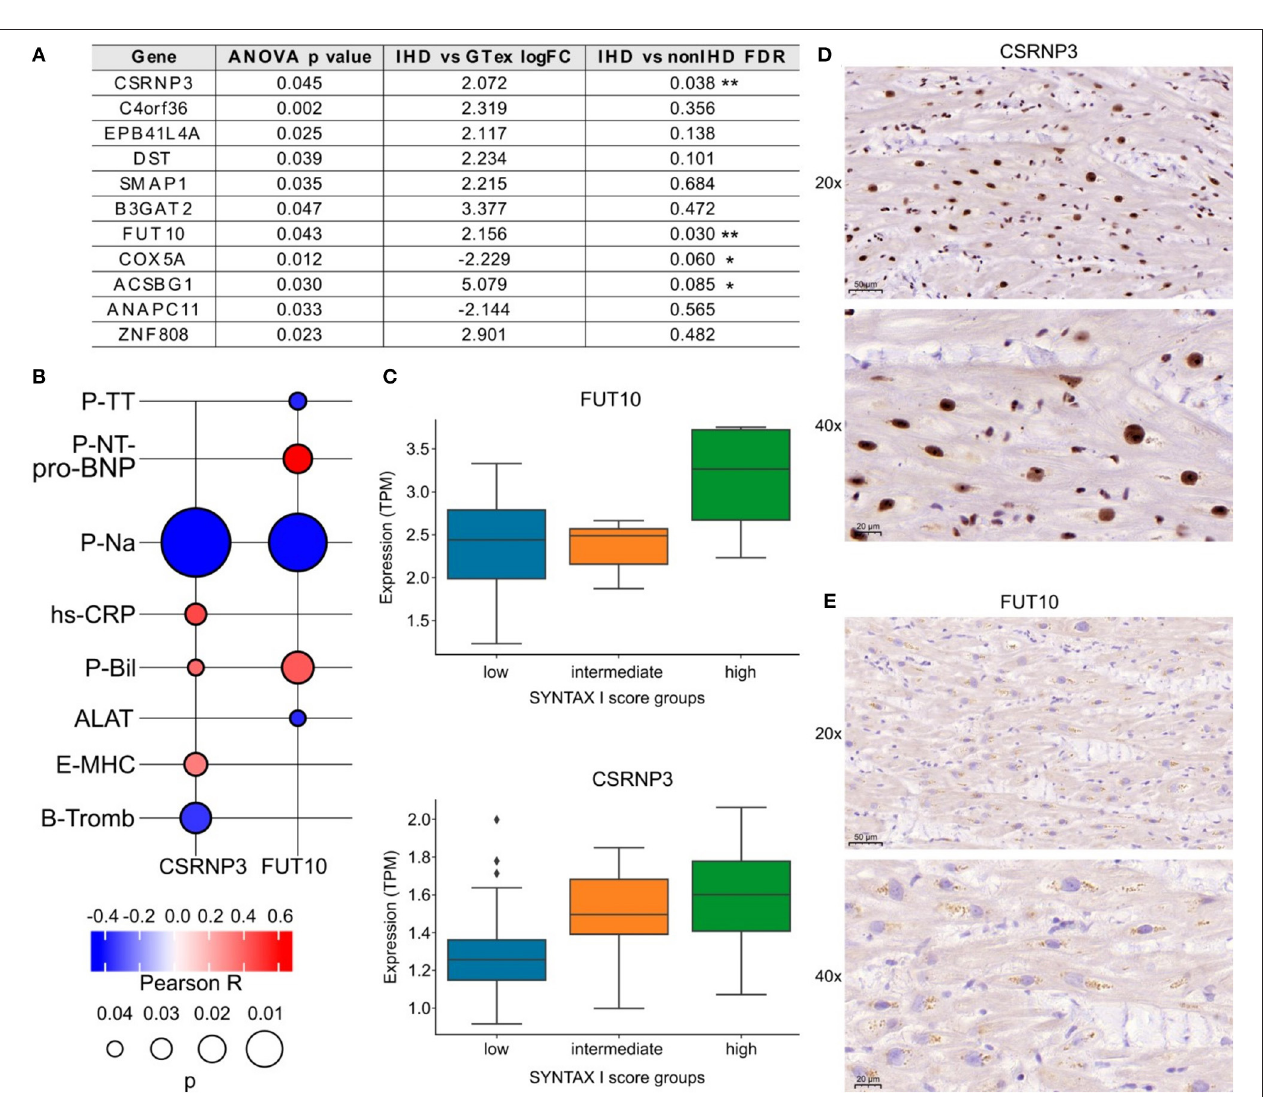
FIGURE 5 | (A) List of genes associated with SYNTAX score I. (B) FUT10 and CSRNP3 correlations with preoperative laboratory tests. The color key illustrates the Pearson R and the size of the bubble indicates the p -value. (C) FUT10 and CSRNP3 expression in the SYNTAX score groups. (D,E) Representative CSRNP3 and FUT10 stainings from the validation